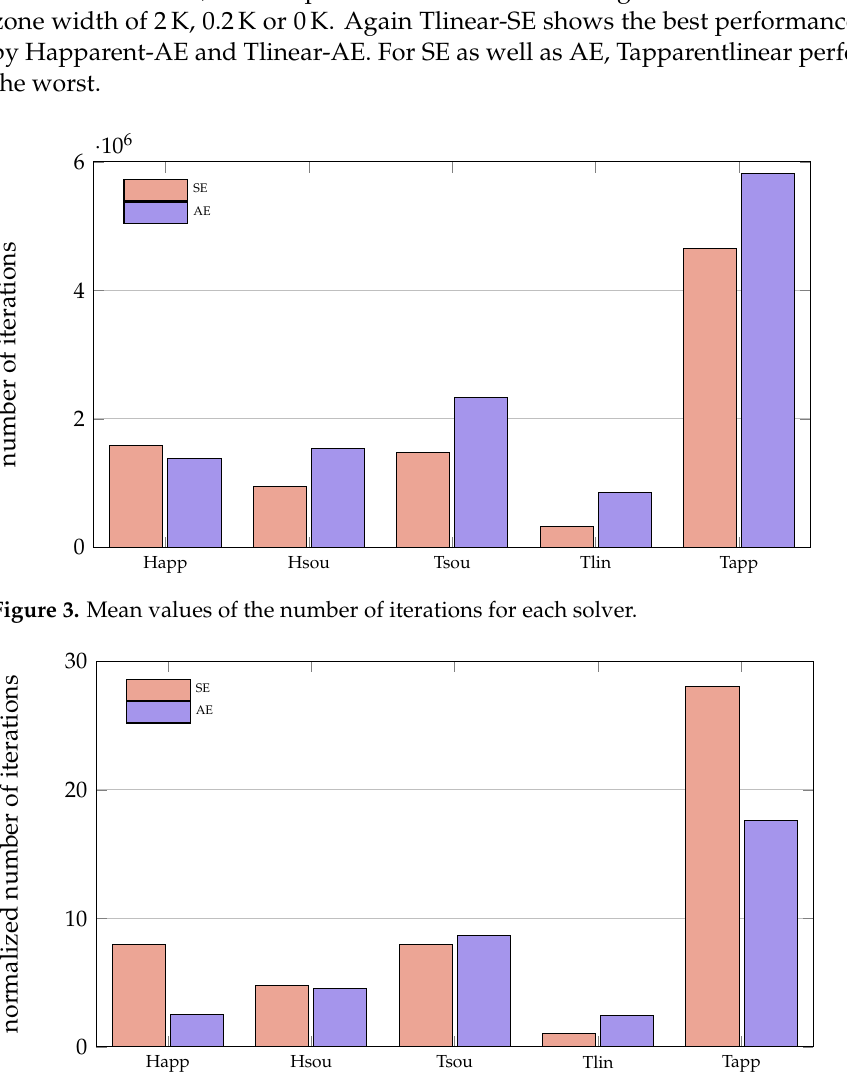
Figure 4. Mean of the normalized iterations for different formulations